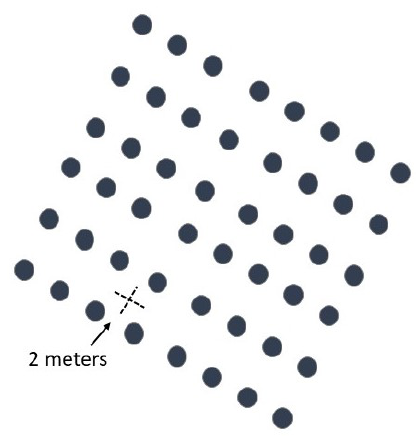
Figure 1. Unconstrained A-B-C model with path coe ffi cients and statistical significance. ** p < 0.01. β values for boys are above the path and β values for girls are below the path. All the conditions were satisfied in boys, except for condition 3. That is, the Loglikelihood Chi Square Di ff erence Test was statistically reliable, indicating that PD functioned as a partial mediator. The direct e ff ect between SV and emotional and physical TDV in the A-C model was significant ( β = 0.47 and β = 0.49, respectively, p < 0.01) and, although its magnitude decreased slightly after entering PD as a mediator in the Unconstrained A-B-C model ( β = 0.41 p < 0.01 for both types of TDV), it remained significant. The indirect e ff ect between SV and emotional and physical TDV through the mediation of PD was small but significant for both types of TDV ( β = 0.06, p < 0.05 and β = 0.08, p < 0.01, for emotional and physical TDV, respectively). In a similar way, all the conditions were satisfied in girls, except for condition 3. That is, the Loglikelihood Chi Square Di ff erence Test was statistically reliable, indicating that PD also functioned as a partial mediator. However, the overall fit of the models was worse in girls than in boys. The direct e ff ect between SV and emotional and physical TDV in the A-C model was also significant although weaker than in boys ( β = 0.42, p < 0.01 for both types of TDV). Furthermore, the magnitude of the direct e ff ect after entering PD as a mediator in the Unconstrained A-B-C model barely changed ( β = 0.40, p < 0.01 for both types of TDV). Accordingly, the indirect e ff ect between SV and emotional and physical TDV through the mediation of PD was four times smaller than in boys, and it was only significant for physical TDV ( β = 0.02, p < 0.05). In sum, the analyses conducted revealed that PD worked as a partial mediator in the relation betweenSVandbothtypesofTDVinthecaseofboys, andbetweenSVandphysical, butnotemotional, TDV in the case of girls. For both, boys and girls, the direct e ff ect between SV and TDV remained significant after the inclusion of PD in the equation. 4. Discussion The main objectives of the present study were to analyse the prevalence of emotional and physical TDV in a sample of Spanish adolescents and to determine whether PD mediates the relation between SVandTDV.WeexpectedtofindevidenceforthemediatingroleofPDandnogenderdi ff erencesinthe relationships among the study variables. Our findings have yielded gender di ff erences in prevalence of emotional and physical TDV but also in the pattern of relationships among the variables, showing